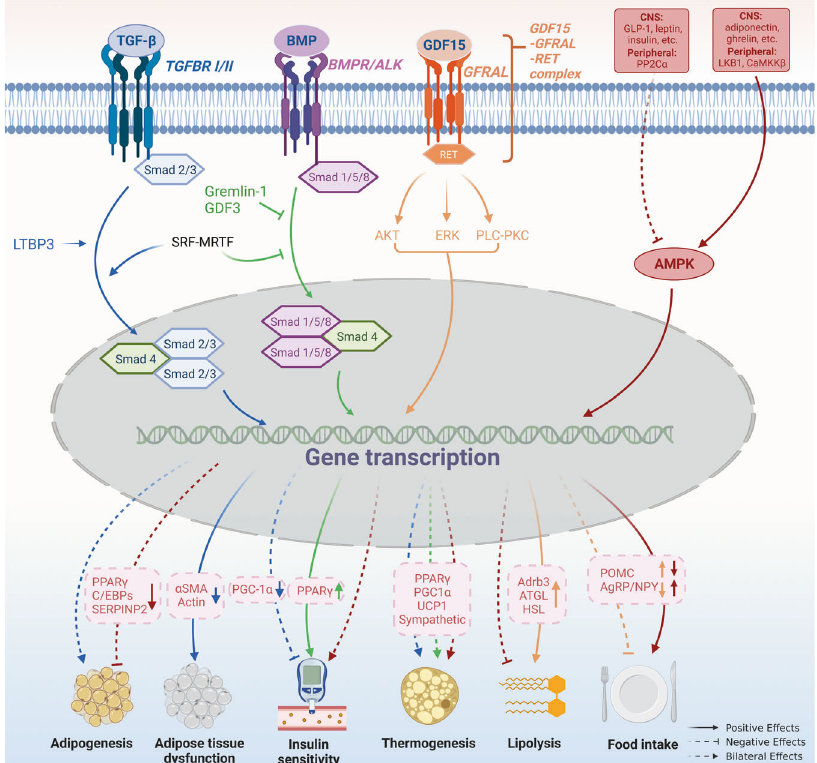
Fig. 3 TGF- β and AMPK signaling pathways in obesity pathogenesis. The TGF- β superfamily consists of TGF- β 1-3, GDFs, BMPs, etc., which play a diverse role in the development of obesity. TGF- β shows dual effects on adipogenesis/adipocyte differentiation. TGF- β inhibits MSC adipocyte commitment by phosphorylating and suppressing PPAR γ and C/EBPs expression, through Smad3 signaling. However, pulsed TGF- β 1 administration during the commitment phase shows a promotion effect on adipogenesis in MSC by down-regulating SERPINB2 expression. In adipocytes, TGF- β signaling is involved in adipose tissue dysfunction by enhancing the expression of myo fi broblast signature genes. The role of TGF- β in BAT-associated thermogenesis is also controversial. Activation of TGF- β signaling by LTBP3 promotes WAT browning by modulating UCP1 expression, while hepatic TGF- β signaling contributes to HFD-induced steatosis and obesity by reducing mitochondrial respiration and inhibiting white-to-beige fat conversion. In addition, SRF - MRTF - axis which transcriptionally enhances the TGF- β but attenuates BMP signaling pathway suppresses brown adipogenesis. TGF- β /Smad3 signaling also plays a negative role in insulin sensitivity by suppressing PGC-1 α expression in adipose tissue. BMP seems to play a contrary role to TGF- β in the regulation of insulin sensitivity by